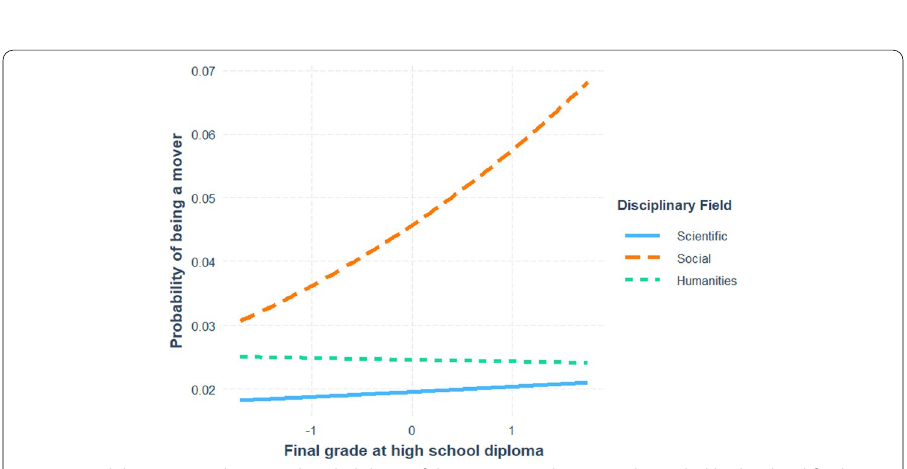
Fig. 8 Model 2: Estimated marginal probabilities of the interaction between the scaled high school final grade and the macro-area of study